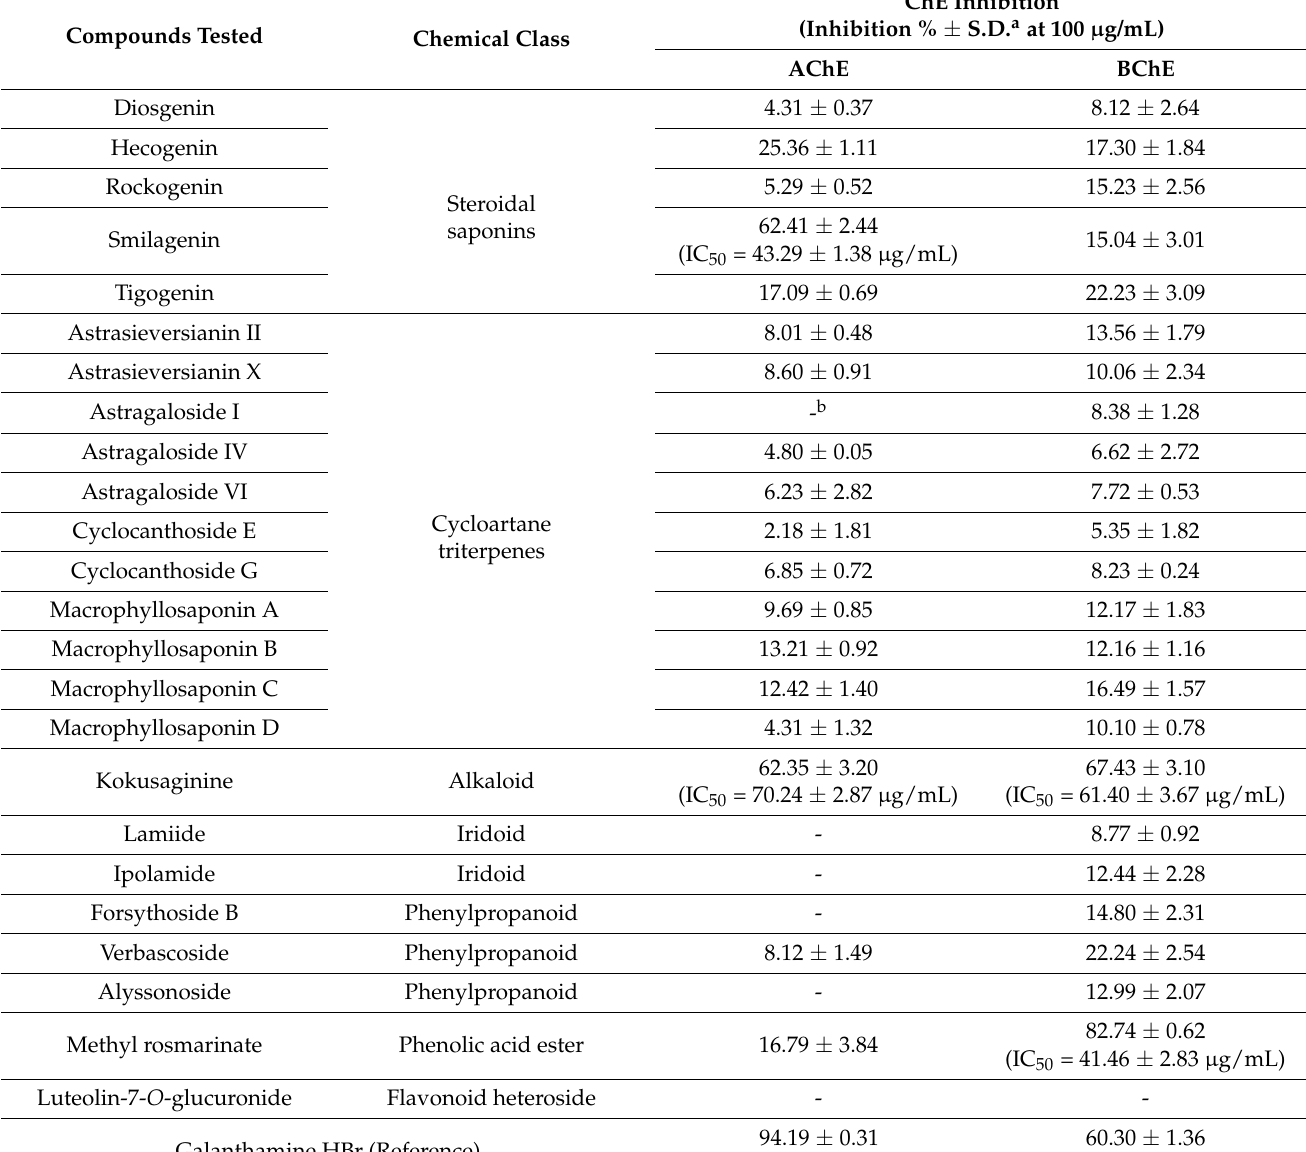
Table 1. ChE inhibitory activity (inhibition% ± S.D. and IC 50 values) of the natural compounds.